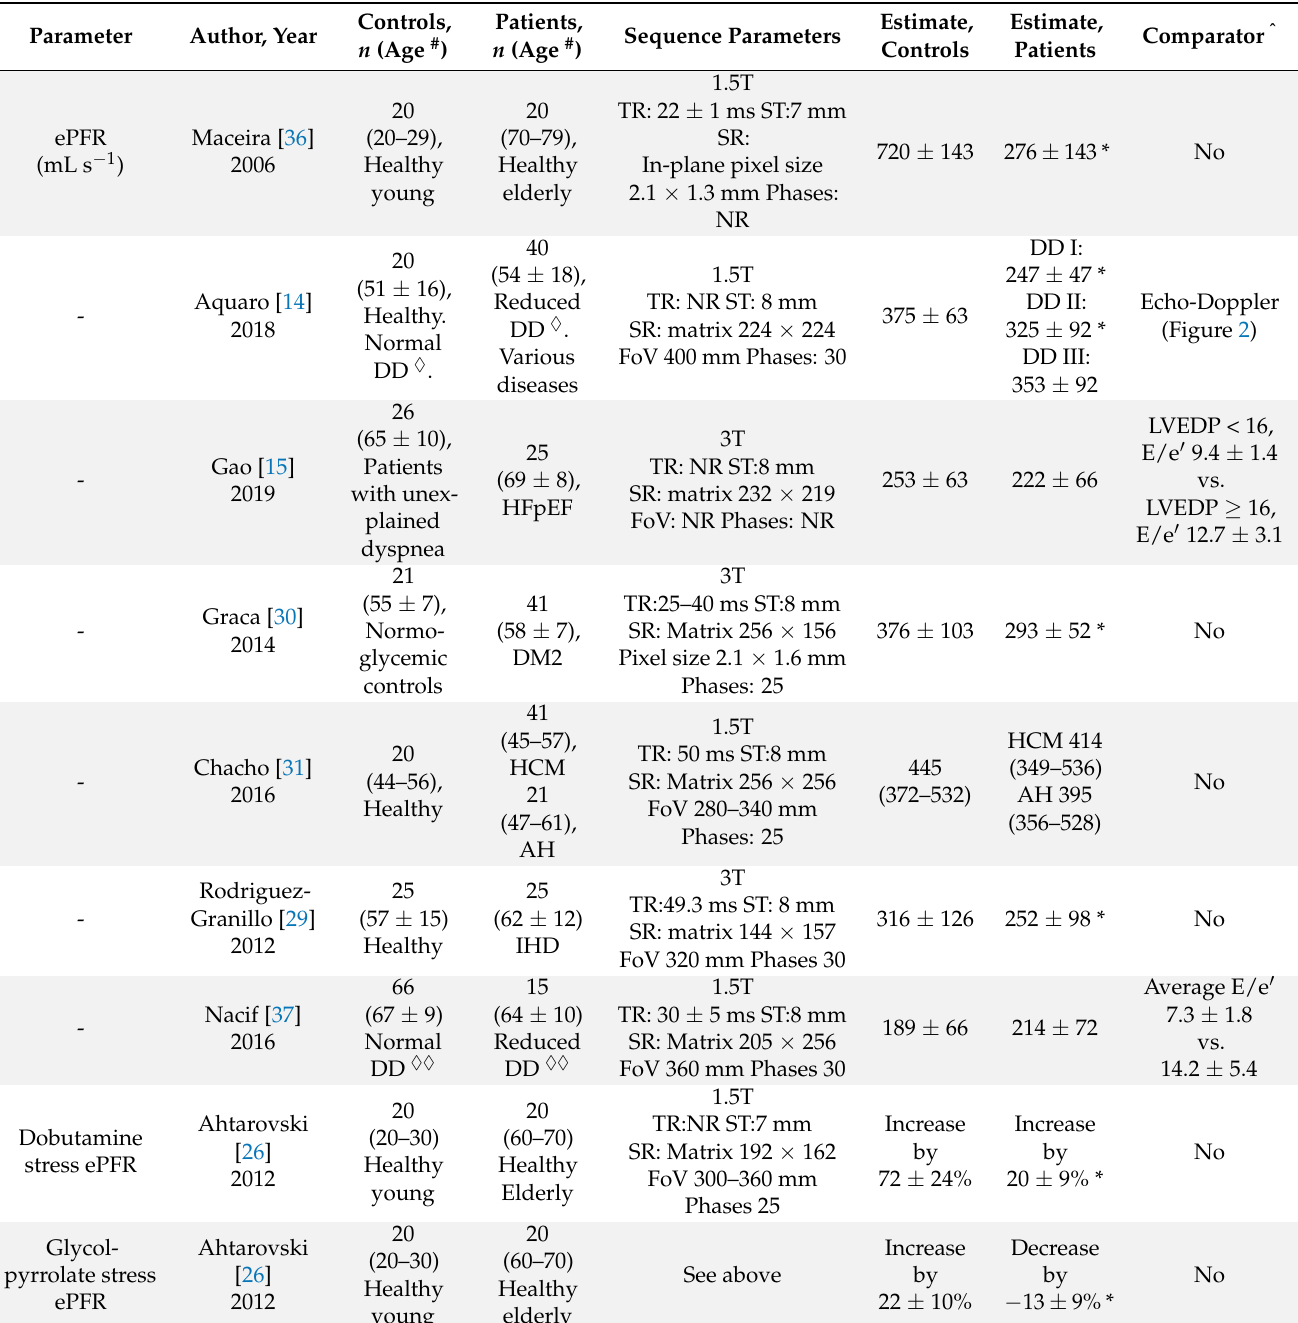
Table 5. LV time/volume curves—early peak filling